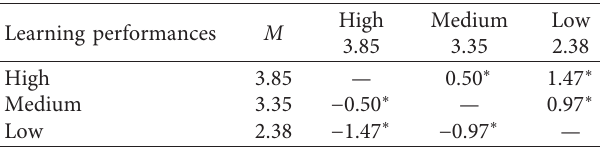
Table 10: Pairwise comparisons of self-efficacy in programming among different learning performances.